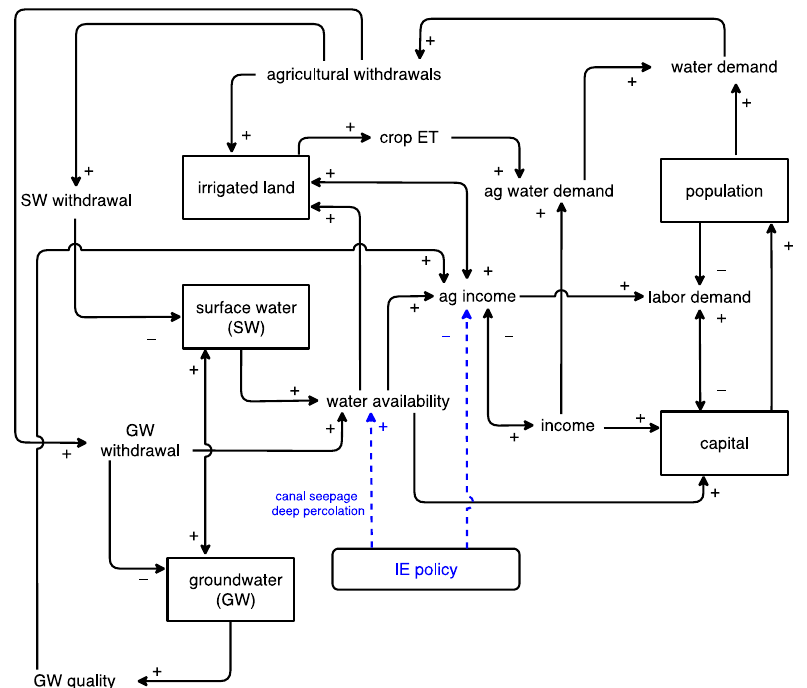
Figure 2. Causal structure of the model: positive or negative causality is marked as plus or minus; double sides arrows explains that two variables have mutual feedback; blue dash line represents where the policy implements.